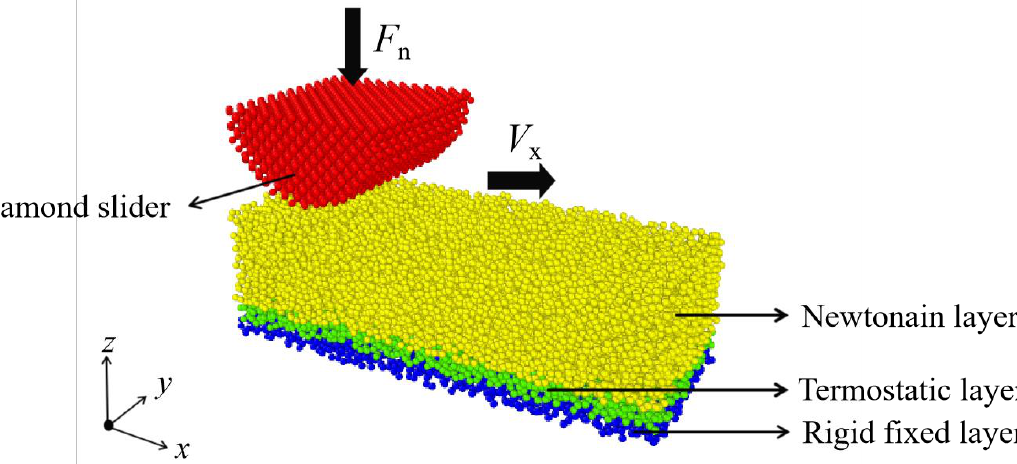
Figure 1. Schematic illustration of MD friction model.